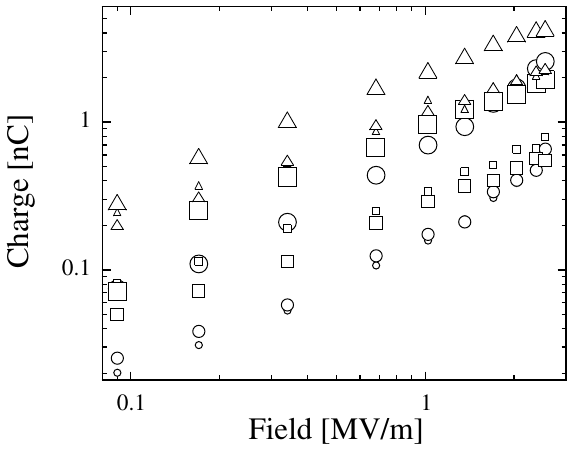
FIG. 4. Experimental total emitted charge versus applied field for various bulk temperatures and deposited energy val- ues. Small symbol to large symbol referred to12, 16, and 22 mJ, respectively, of deposited laser energy. Circles, squares, and triangles referred to 516, 618, and 713 K bulk temperature values, respectively. The general trend is greater emitted charge for increasing applied field, temperature, and laser intensity, as